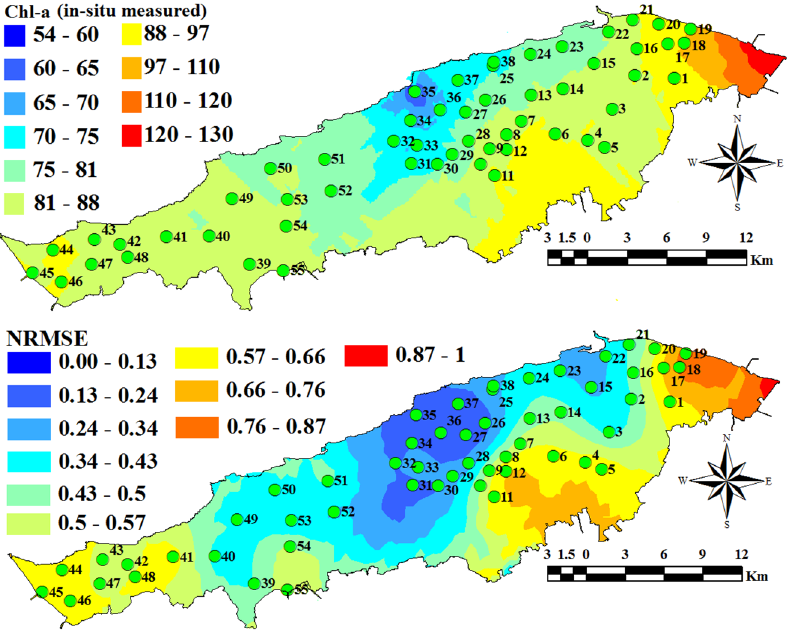
Figure 9. Spatial distribution of the in situ measured Chl- a content and the associated normalized RMSE against the MSI derived Chl- a content.